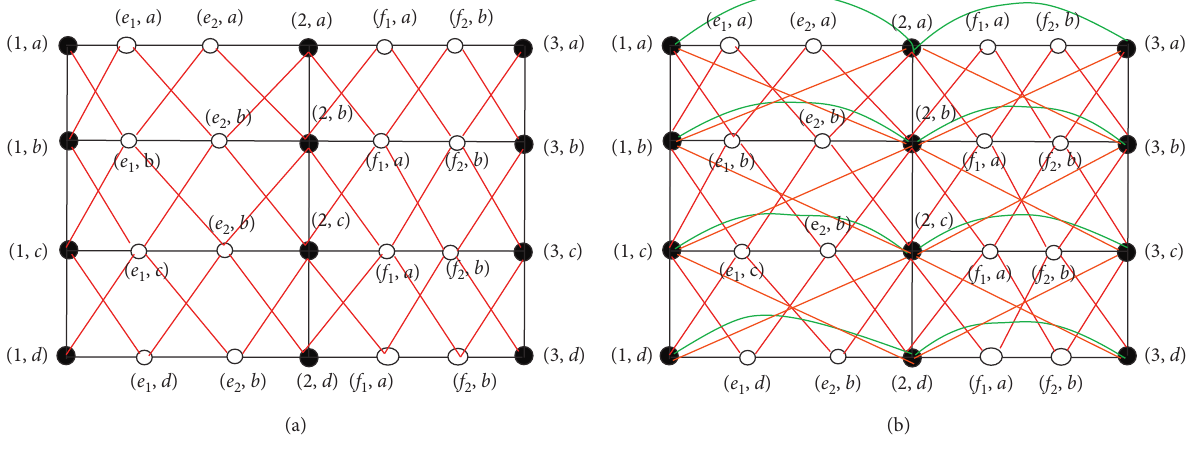
Figure 2: Right: � P